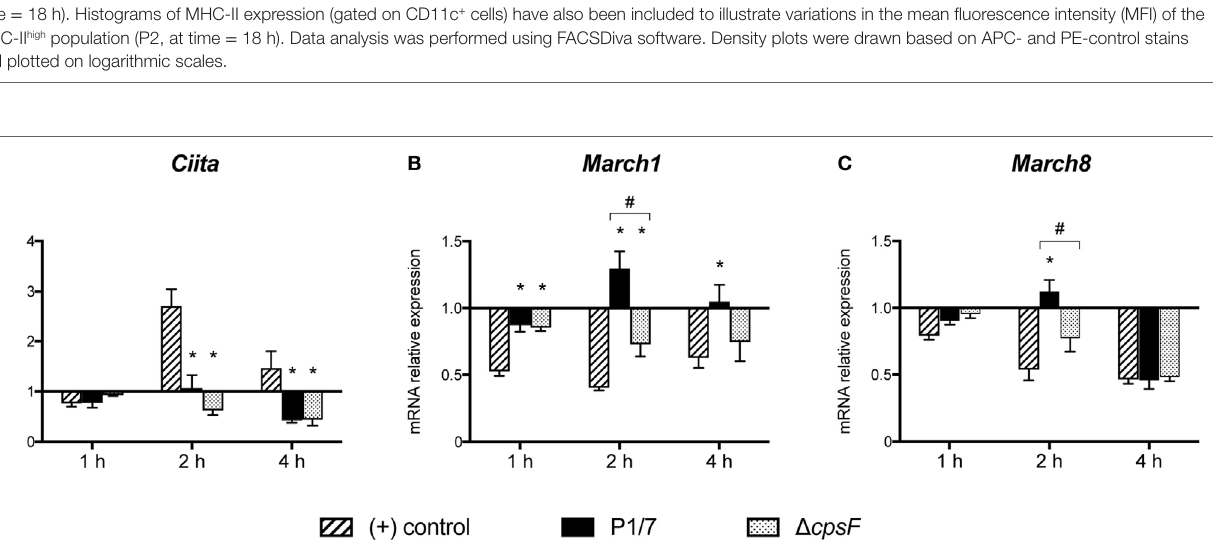
FigUre 4 | Streptococcus suis -stimulated bone marrow-derived dendritic cells (bmDCs) and directly activated bmDCs have distinct Class II Major Histocompatibility Complex Transactivator (CIITA), MARCH1 and MARCH8 transcriptional profiles. BmDCs were stimulated for 1, 2, or 4 h with S. suis wild-type (WT) strain P1/7 or the non-encapsulated mutant Δ cpsF (initial MOI:1) in technical duplicates. Total cellular RNA was extracted and analyzed by RT-qPCR for (a) CIITA , (B) MARCH1, and (c) MARCH8 mRNA expression. Expression is illustrated as fold level over unstimulated cells [( − ) control]. Cells stimulated with lipopolysaccharide (LPS) (1 µg/ml) served as positive ( + ) control. Data are expressed as mean ± SEM from four independent experiments. *P < 0.05 indicates a statistically significant difference compared to ( + ) control cells. # P < 0.05 indicates a statistically significant difference between P1/7-stimulated bmDCs and Δ cpsF -stimulated bmDCs.